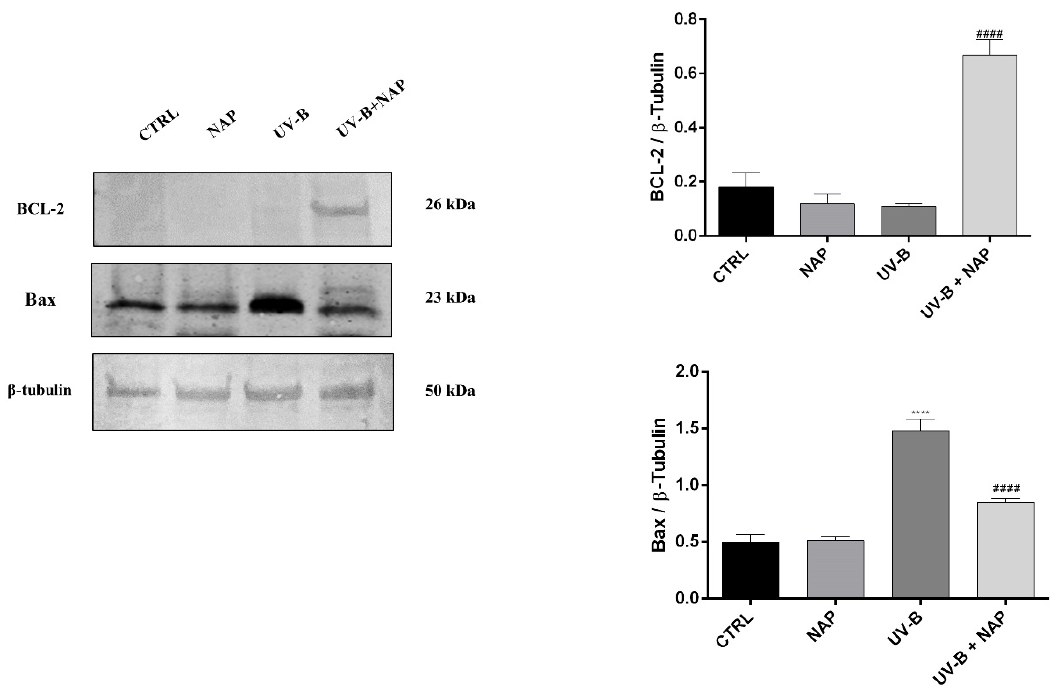
Figure 5. Effect of NAP on Bcl-2/Bax expression of corneal epithelial cells exposed to UV-B rays. Representative immunoblot of Bcl-2 and Bax protein expression in SIRC cells cultured in control medium (CTRL) or treated with 10 nM of NAP, or exposed to UV-B irradiation for 30 s with or without 10 nM of NAP. The bar graph shows quantitative analysis of signals obtained by immunoblots resulting from three independent experiments. Relative band densities were quantified by using ImageJ software. Protein levels are expressed as arbitrary units obtained after normalization to β -tubulin, which were used as loading control. Data represent means ± SEM. **** p < 0.0001 vs. CTRL; #### p < 0.0001 vs. UV-B as determined by one-way ANOVA followed by Tukey’s multiple comparison test.